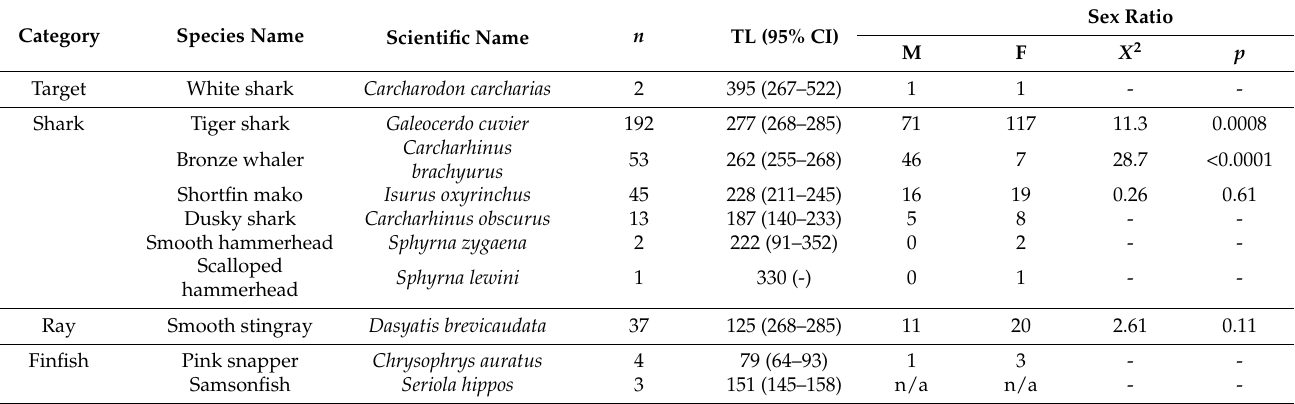
Table 1. Number caught (n), mean total length (TL, in cm) and sex ratio comparisons for the 352 fish caught during the SMART drumline trial. For the smooth stingray, TL = disk width, in cm. The number of males and females does not equal n for all species as it was not possible to ascertain the sex for all